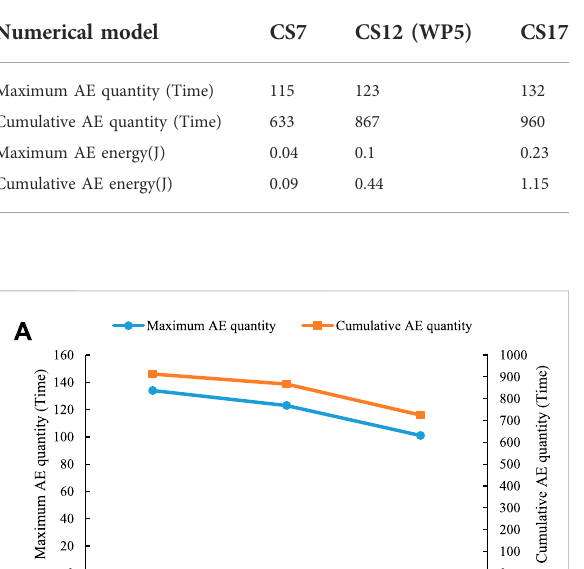
TABLE 3 AE values of samples with different strength under the same lower boundary water pressure.